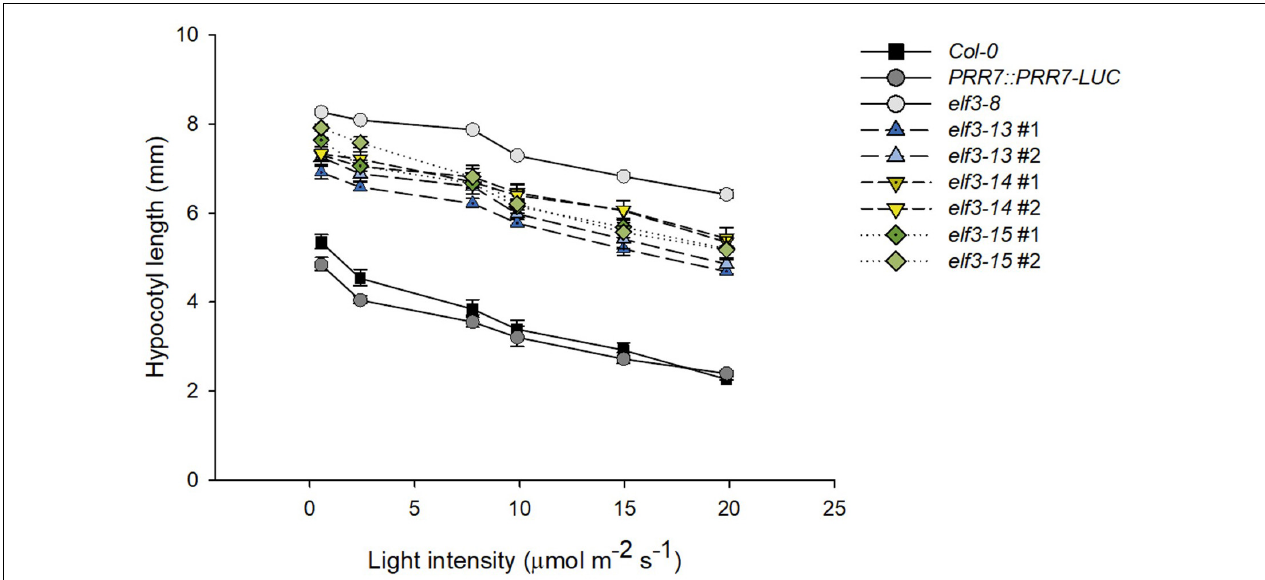
FIGURE 6 | Effect of elf3 mutations on hypocotyl growth. Col-0 WT, PRR7::PRR7-LUC (parent line) elf3-8 , elf3-13 , elf3-14 , and elf3-15 seeds were plated on MS medium without sucrose stratified (4 ◦ C; 4 days) then grown under continuous red light at the indicated light intensities. Error bars indicate ± SEM ( n = 3).